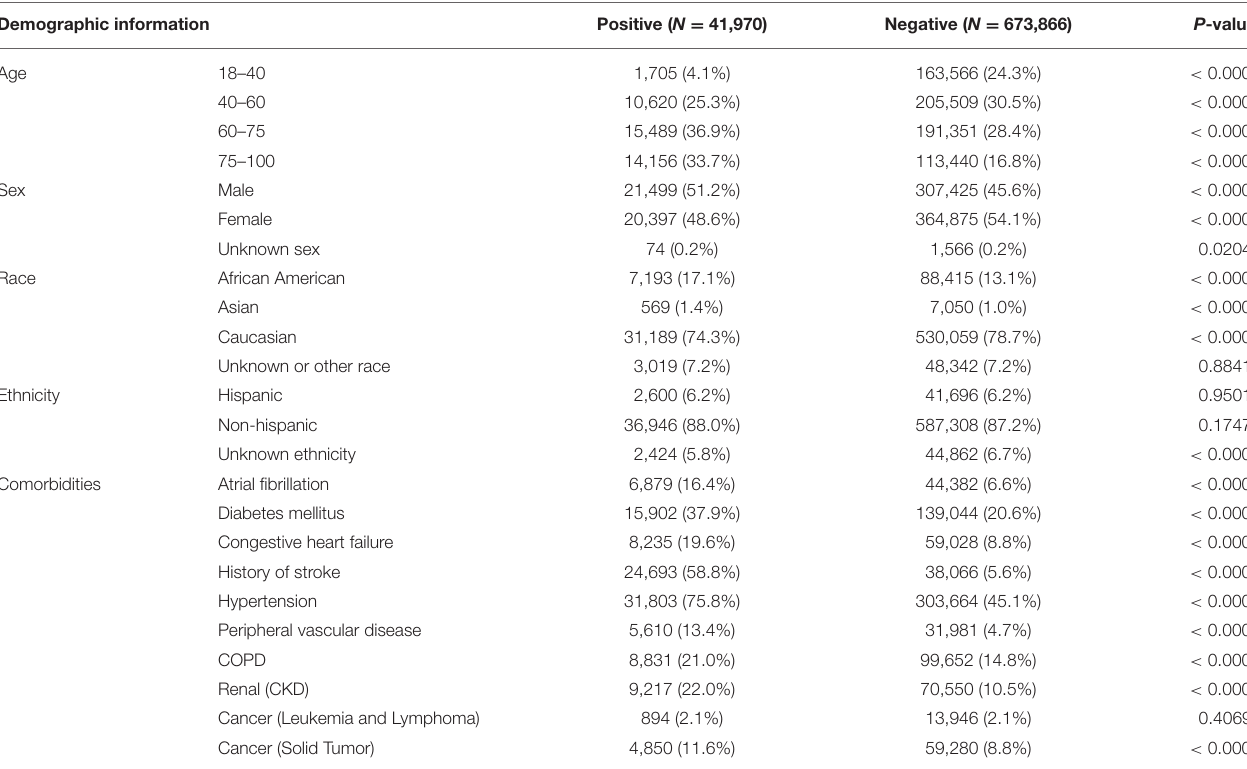
TABLE 3 | Demographic information for the study population sample in the training and testing of the algorithm. Demographic